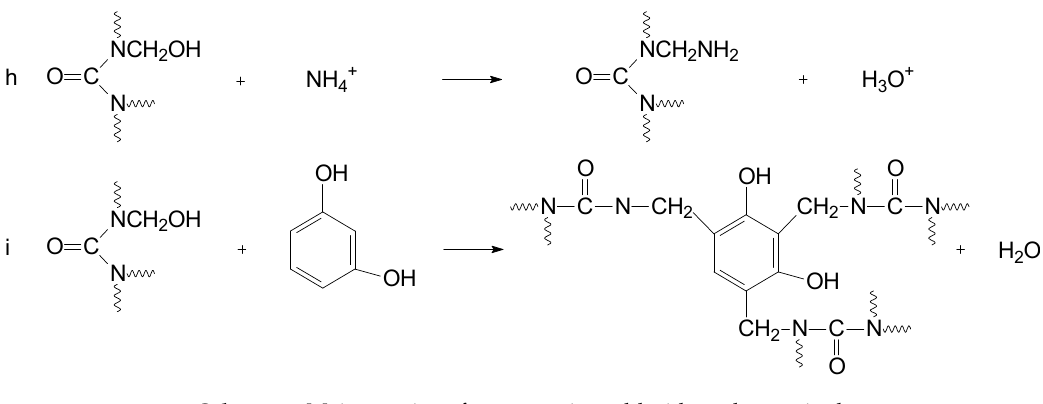
Scheme 2. Main reactions for ammonium chloride and resorcinol.